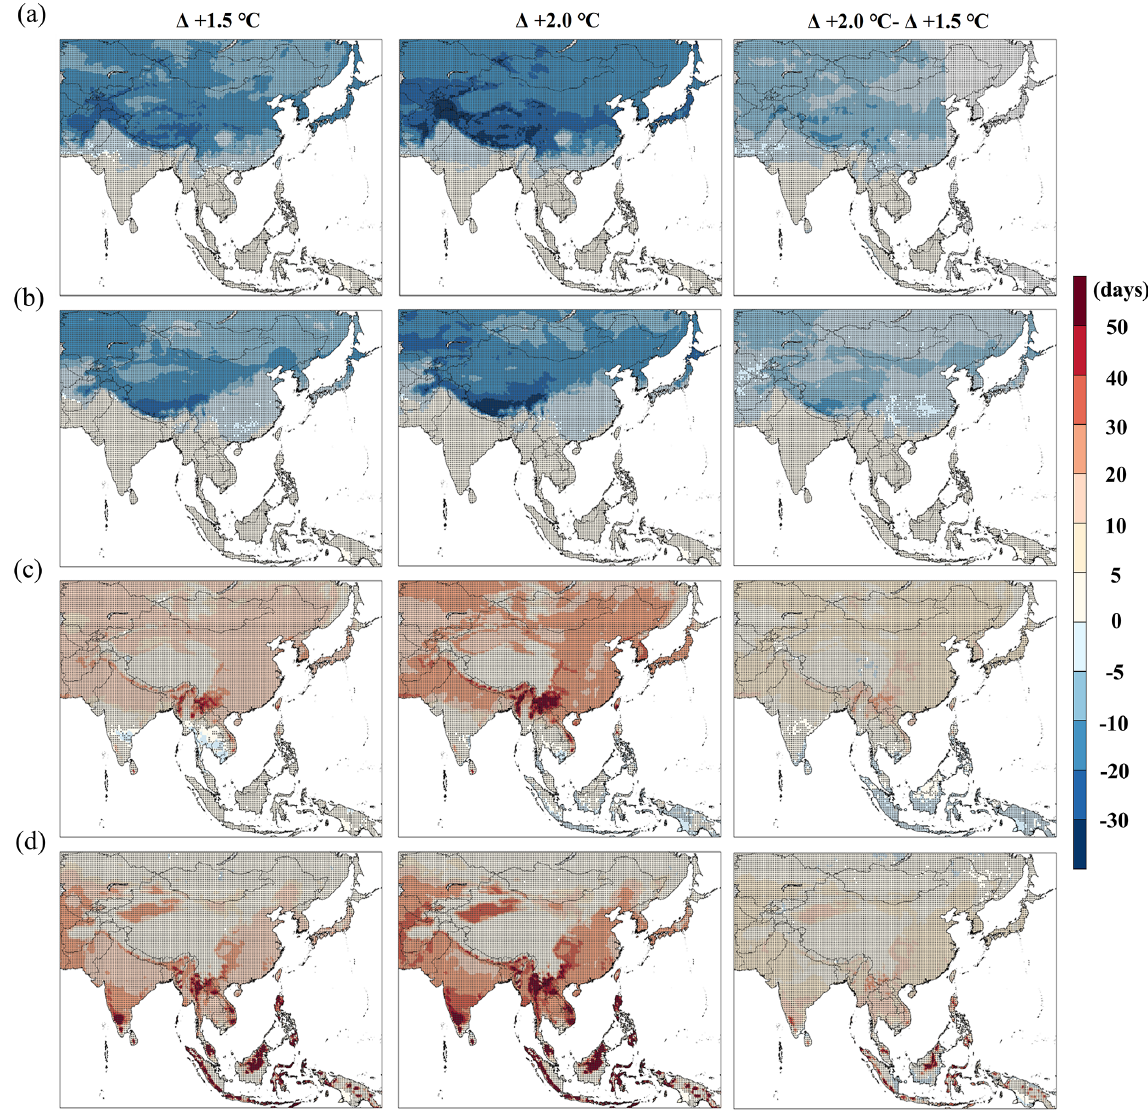
Figure 4. Spatial distributions of the MME for four extreme climate indices (FD, ID, SU, and TR) over the study domain. The relative changes in the numbers of (a) frost days (FD), (b) ice days (ID), (c) summer days (SU), and (d) tropical nights (TR) for 1.5 and 2.0 ◦ C of global warming under RCP4.5 are compared with those of the reference period